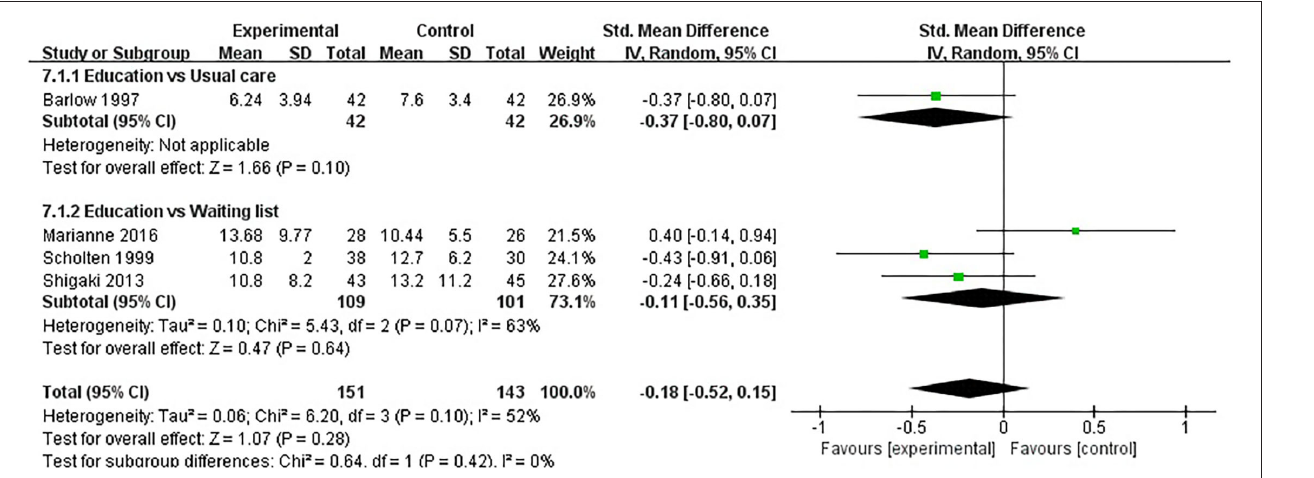
FIGURE 8 | Meta-analysis on